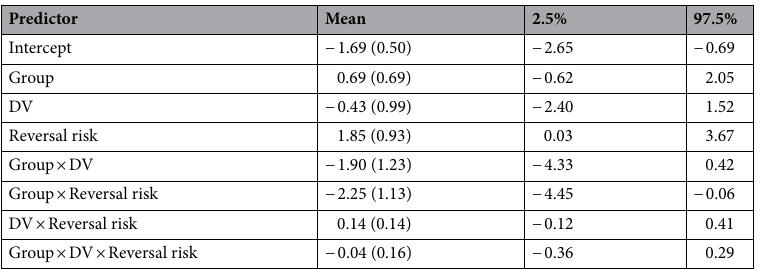
than non-smokers, Group × Reversal risk: HDI mean = − 2.25, HDI 95% = [− 4.45; − 0.06] (Fig. 3B and Table 4). The Group × Reversal risk interaction remained significant when controlling for BIS/BAS scores, age, and educational